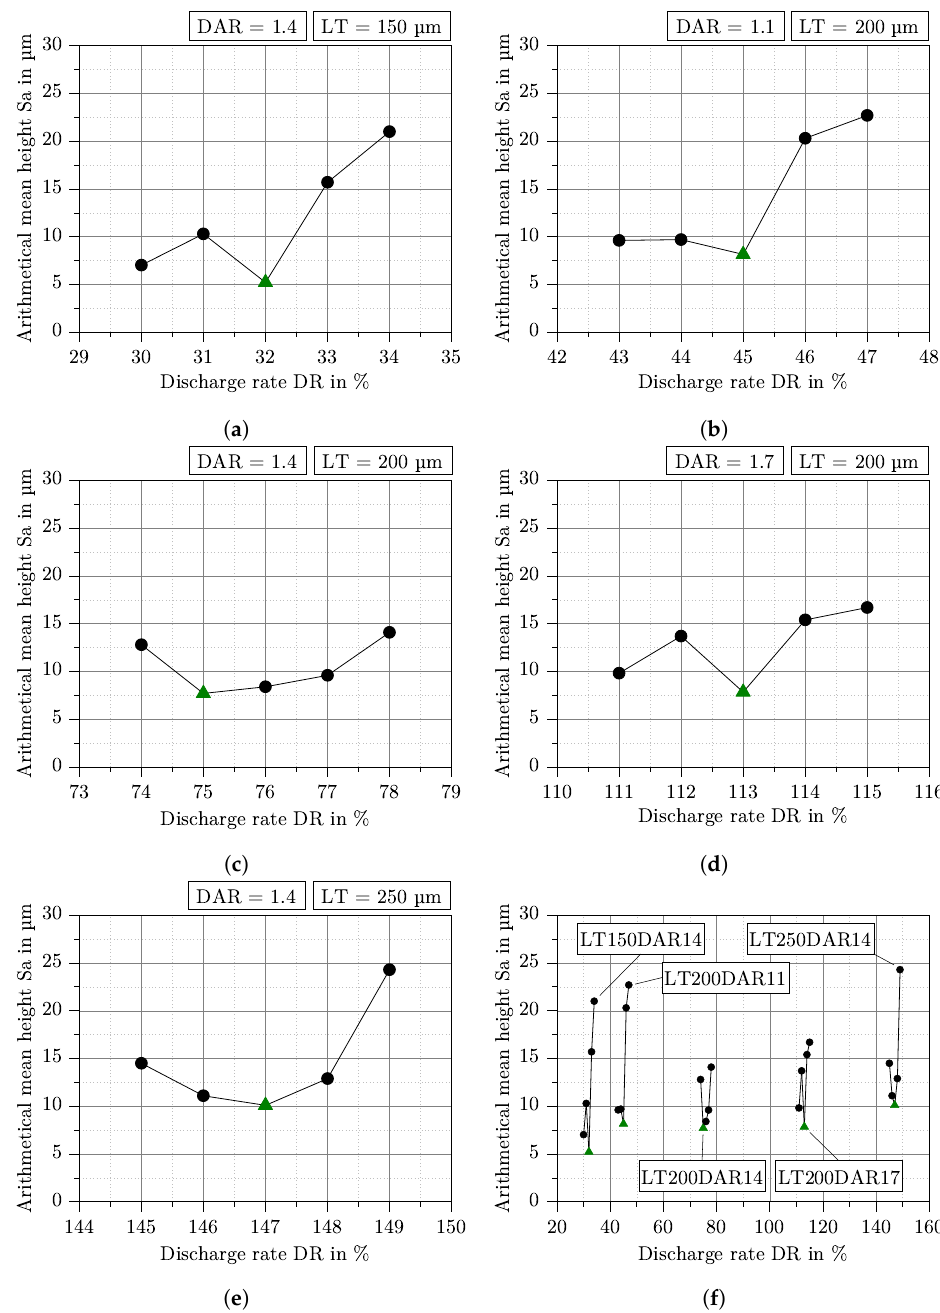
Figure 5. Arithmetical mean height Sa above the DR for the five LT-DAR combinations from Table 2. The range of DR is only 5% compared to the density measurement in Figure 3. The minimum of Sa is marked with a green triangle. ( a – e ): Sa for the individual LT-DAR combinations. ( f ) Comparison of all LT-DAR